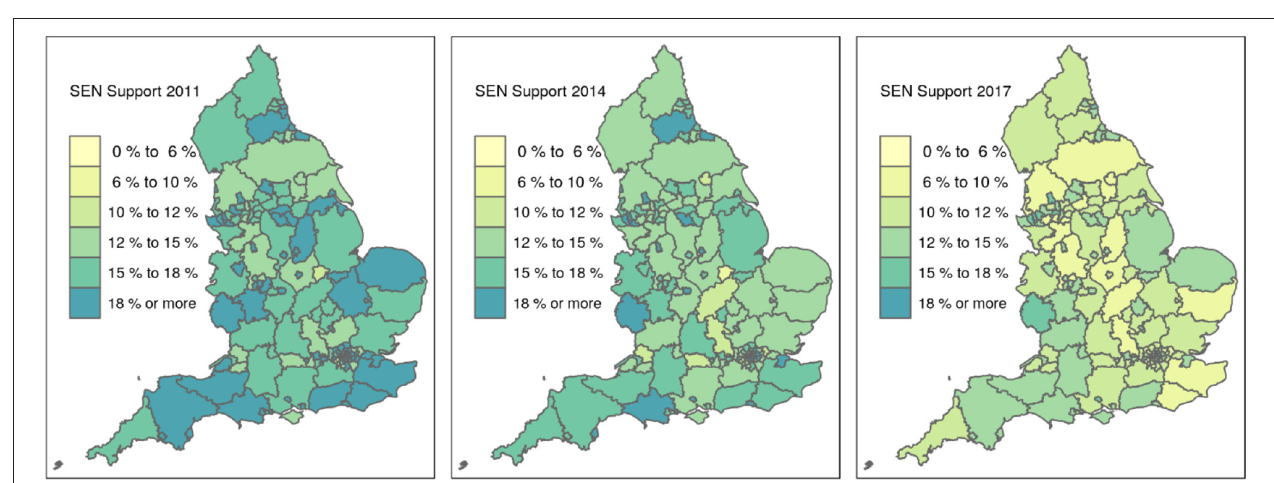
FIGURE 6 | The percentage of pupils with SEN Support by local authority, England,